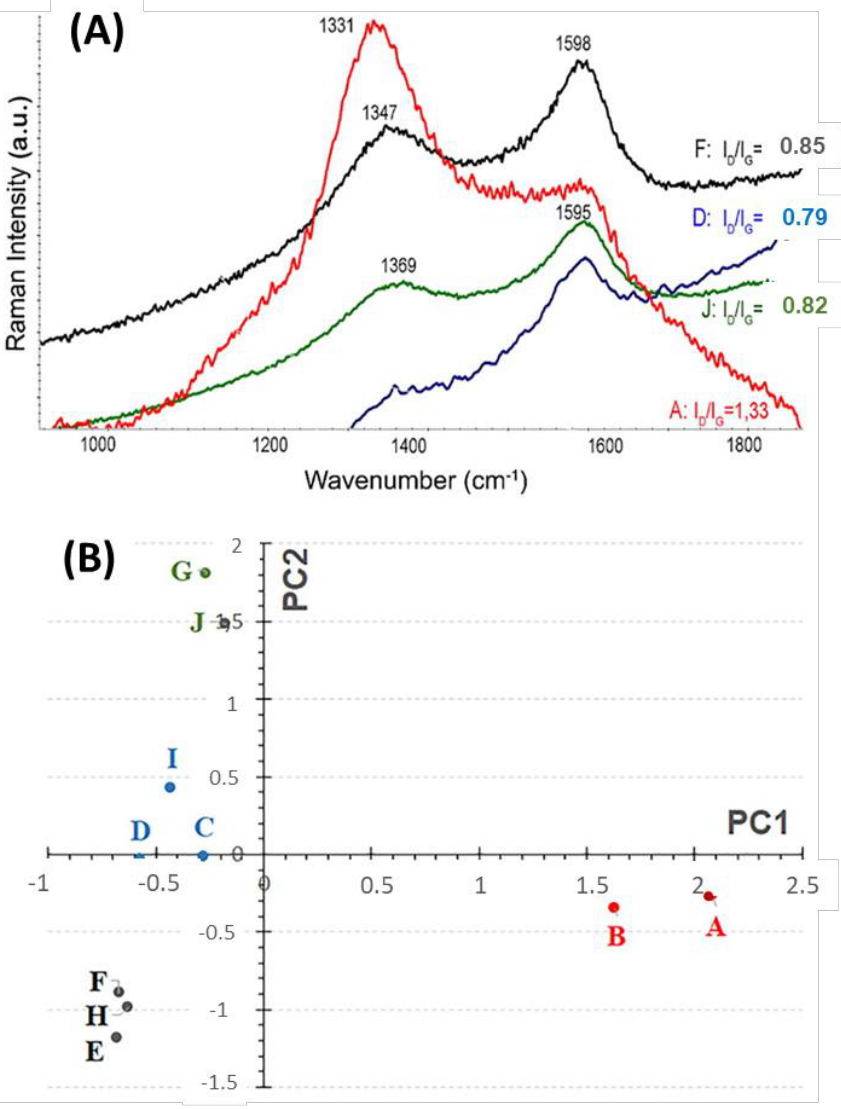
Figure 6. Ref. [112]. ( A ) Two-peak fitting results from Raman spectra of four BC particles (A, D, F, and J) from different Antarctic aerosol samples. ( B ) Scores from statistical analysis from Raman spectra of BC particles from PCA of two PCs (group 1: A and B; group 2: C, D, and I; group 3: G and J; group 4: F, H, and E).